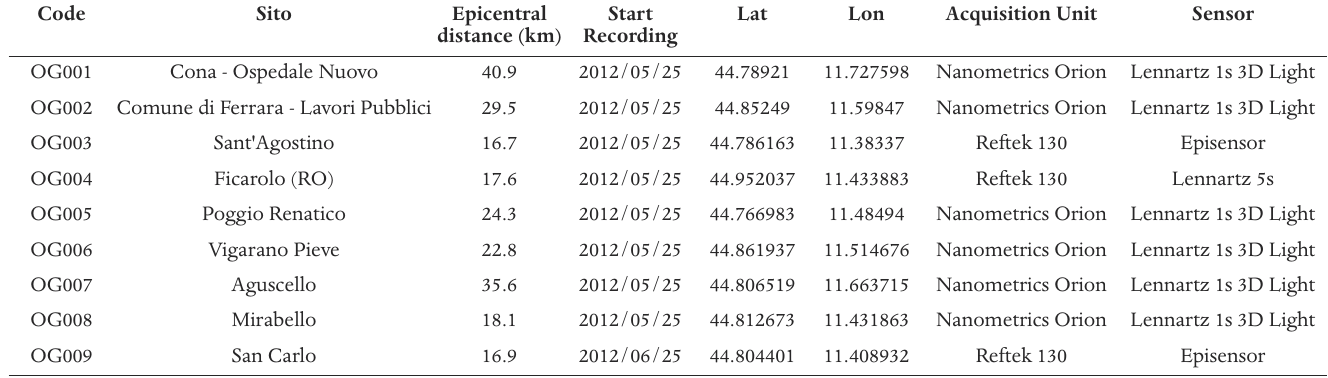
Table 1. Detail of the OGS temporarty